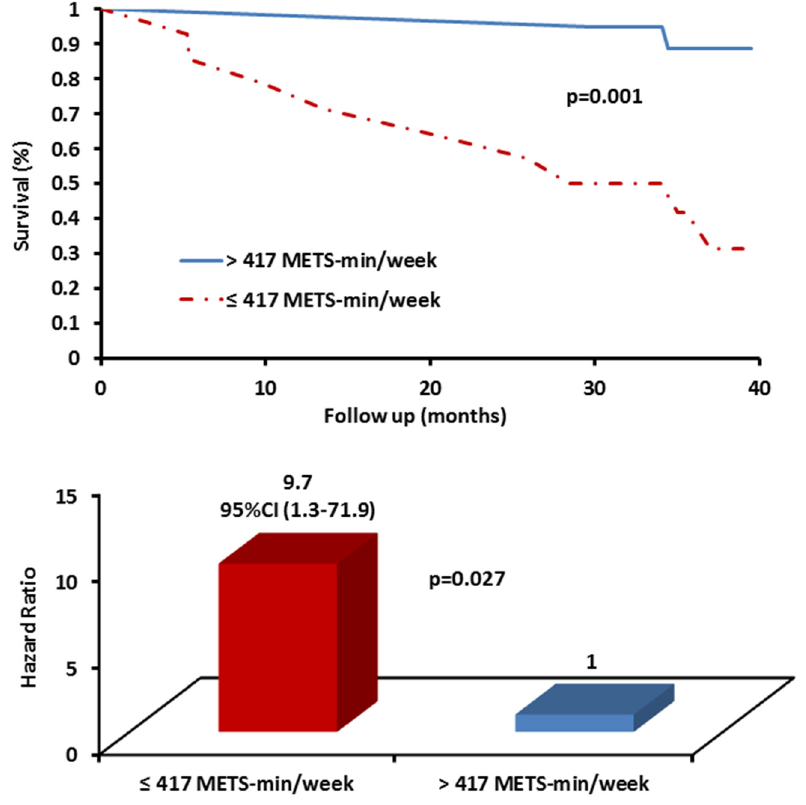
Figure 1. Kaplan–Meir survival curves and hazard ratio for physical activity threshold in patients with idiopathic pulmonary fibrosis.